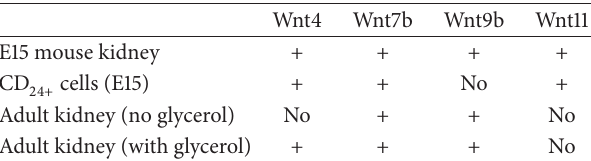
0.5 million CD 24+ PKH26 red-stained embryonic kidney Table 1: Wnt mRNA expression in mouse embryonic and adult